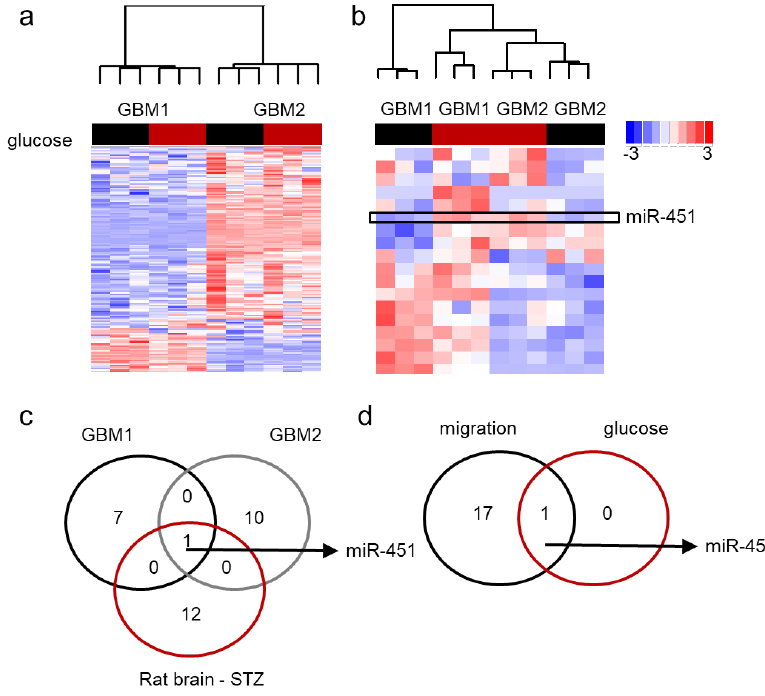
Figure 4. miR-451 is specifically down-regulated in low glucose in GBM cells. ( a , b ) Unsupervised clustering of microRNA by Nanostring analysis; red bar: high glucose, black bar: low glucose. ( a ) microRNAs significantly different in two GBM cell lines cultured for 24 h in high (+) and low ( − ) glucose conditions. ( b ) microRNAs significantly different in both glucose regimens in at least one cell line; box: miR-451. ( c ) Venn diagram showing number of microRNAs significantly deregulated in glucose-deprived GBM cells and brains of STZ-treated rats. ( d ) Venn diagram showing number of microRNAs significantly deregulated in glucose-deprived GBM cells and during 3D spheroid dispersal assay (3